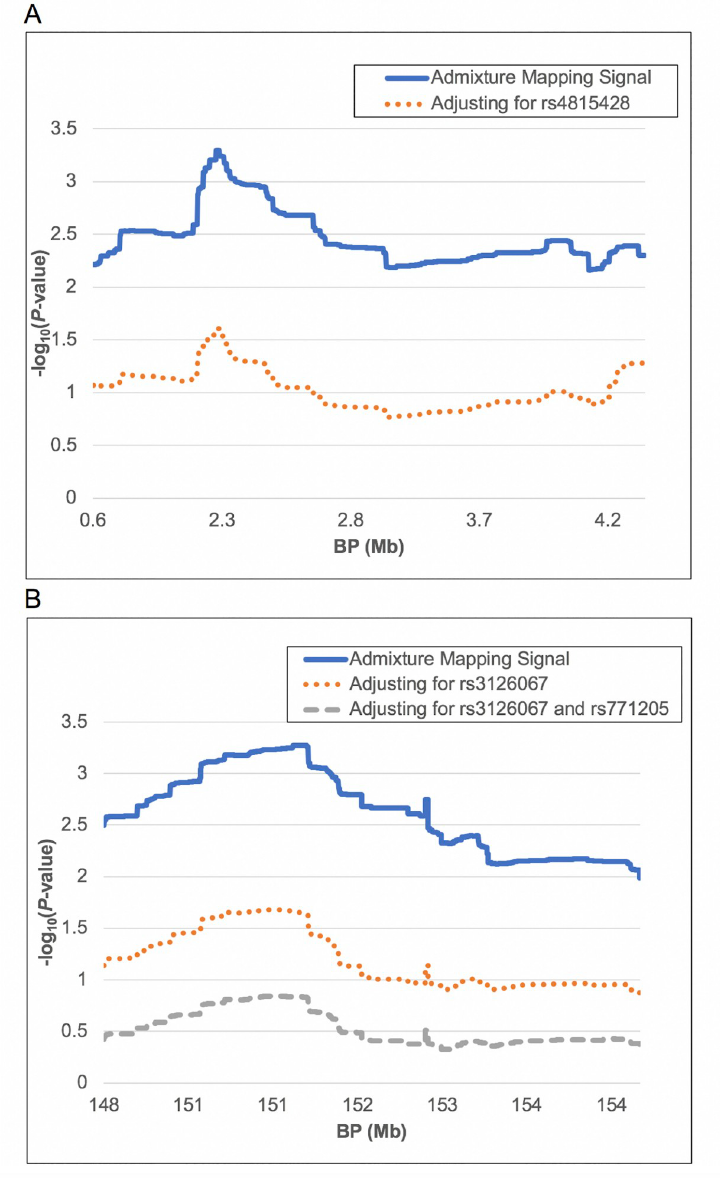
Fig 2. Conditional admixture mapping study in DBP significant region chr20:0.6–5.3 Mb and MAP significant region chr1:148.2–153.3 Mb. A) For DBP in the region of chr20:0.6–5.3 Mb, after adjusted for SNP rs4815428, the significant signal partially disappeared. SNP rs4815428 partially explained the significant admixture mapping signal in this region. B) For MAP in the region of chr1:148.2–153.3 Mb, after adjusted for SNPs rs3126067 and rs771205, the significant signal completely disappeared. These two SNPs fully explained the significant admixture mapping signal in this region. The x-axis is not to scale due to missing intronic regions.